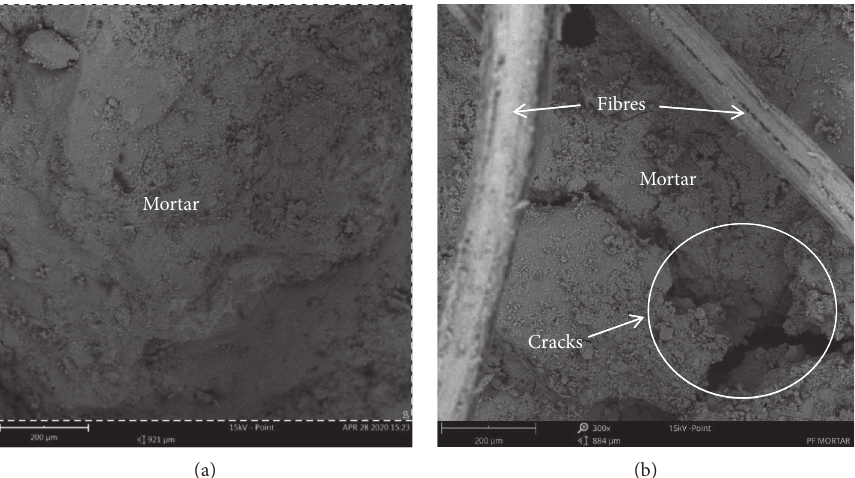
Figure 8: SEM images (300 x ) of unreinforced mortar and plantain pseudostem fibre reinforced mortar. (a) Image of unreinforced mortar. (b) Image of fibre reinforced